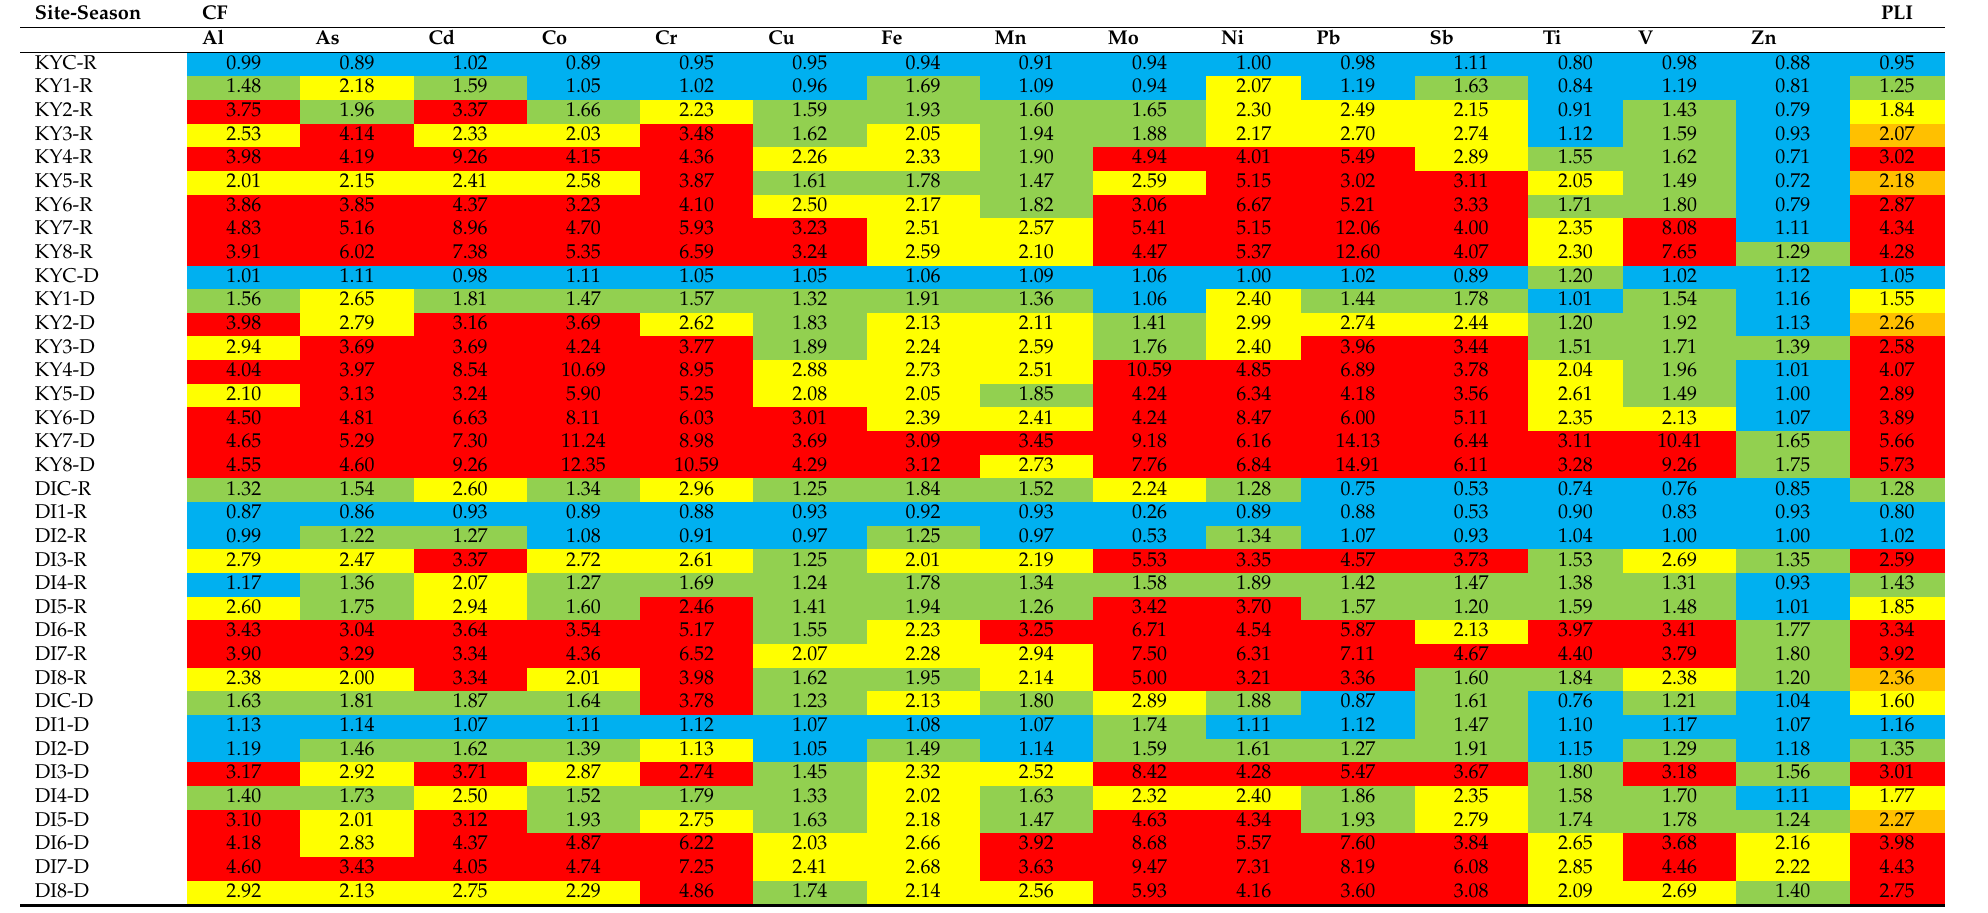
Table 3. Contamination factors (CFs) of each PTE and pollution load indices (PLIs) of each site during the rainy (R) and dry (D) seasons in Khao Yai National Park (KYC, KY1–KY8), and Doi Inthanon National Park (DIC, DI1–DI8) assessed by the transplanted lichen Parmotrema tinctorum .